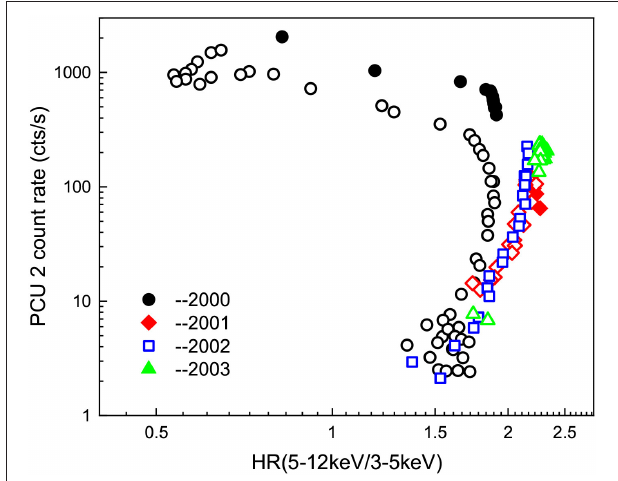
FIGURE 2 | The hardness-intensity diagrams of XTE J1550-564 in 2000, 2001, 2002, 2003, where the filled and open points represent the observations in the rise phase and in the decay phase, respectively.